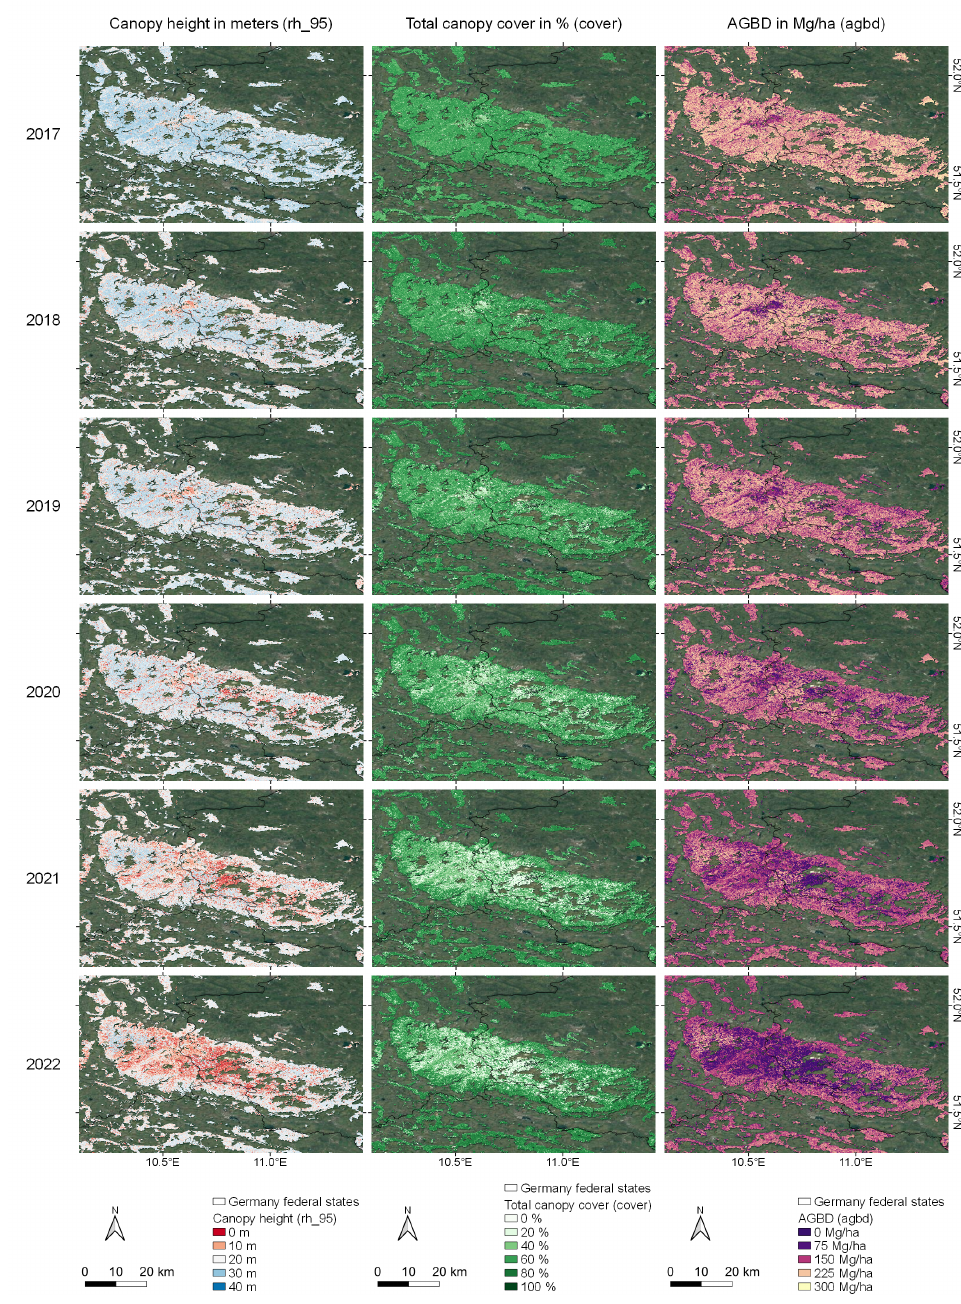
Figure 8. Forest structure change in the Harz region (2017 to 2022) presenting massive changes in forest structure since